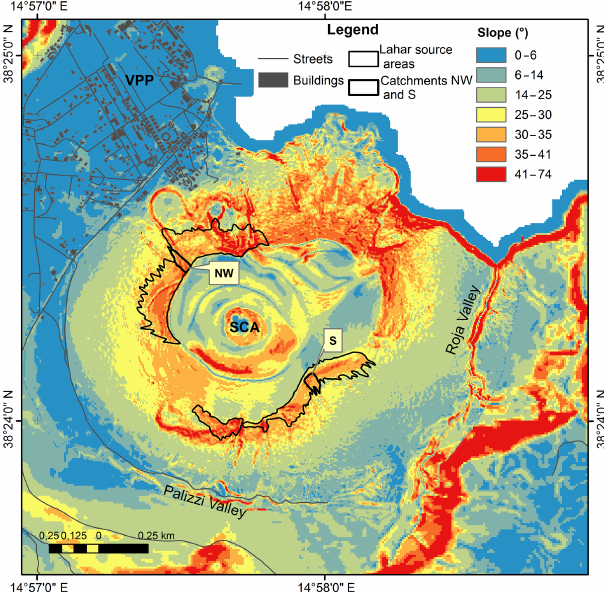
Figure 6. Slope map for the La Fossa cone and surrounding areas. Northwestern and southern lahar source areas are indicated with a black contour. The NW and S upper catchments are indicated with a black contour. SCA: summit cone area; VPP: Vulcano Porto